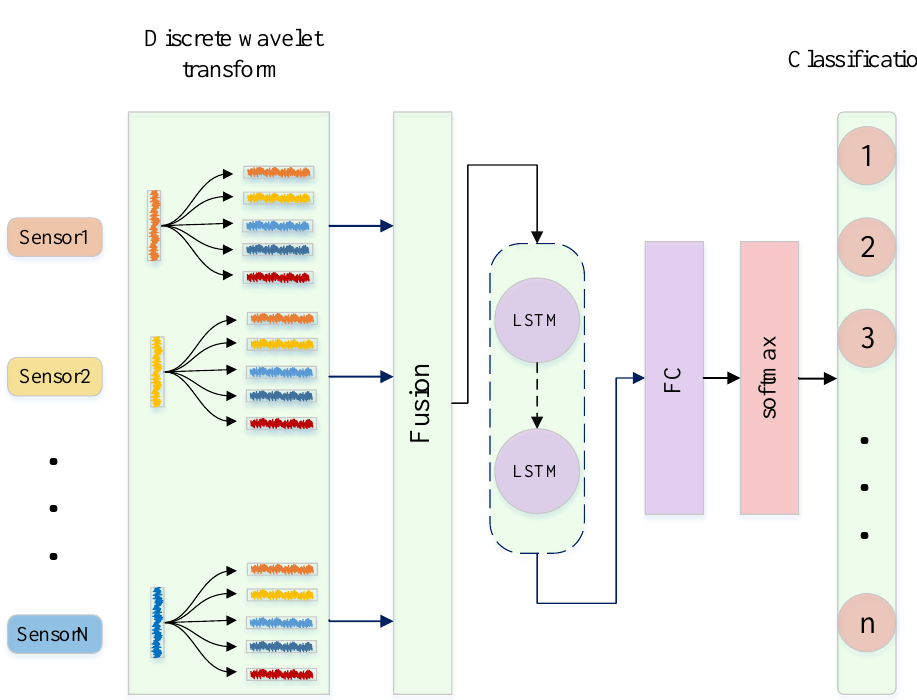
Figure 1. The architecture of the DWT-LSTM